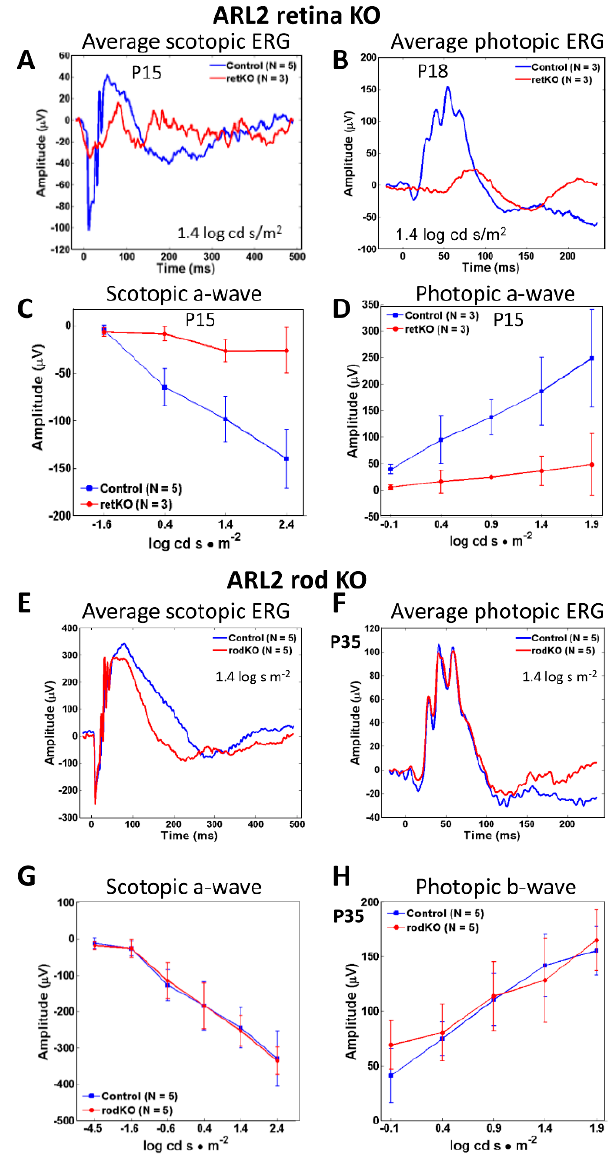
Figure 4. ERG of retina and rod ARL2 knockouts. ( A , B ) averaged ( n = 3–5) pan-retina ERGs at P15 and P18. Average scotopic a- and photopic b-wave amplitudes revealed diminished amplitudes. Control ERGs are shown in blue, ret Arl2 − / − ERGs in red. ( C , D ) scotopic a- and b-wave amplitudes as a function of light intensity. Note near complete extinction of responses. ( E , F ) P35 rod knockout ERGs. Average scotopic a-wave ( E ) and photopic ( F ) b-wave amplitudes ( n = 5) of control (blue) and rod KO (red) as a function of flash intensity. Control and knockout scotopic a- and b-wave amplitudes are nearly identical. ( G , H ) scotopic a-wave ( G ) and photopic b-wave ( H ) as a function of light intensity. Rod knockouts shown in red, controls in